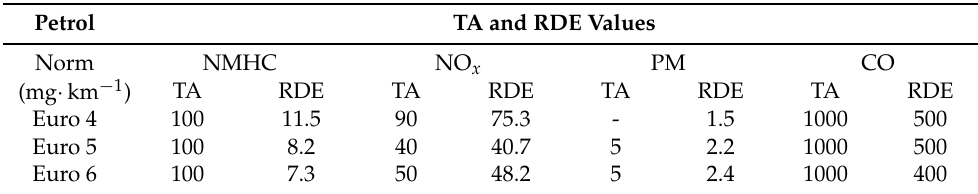
Table 4. Overview of the type approval (TA) values and applied real driving emission (RDE) values for the regulated pollutants for diesel cars (based upon [21,39,43,54–57]). Diesel TA and RDE Values Norm NMHC NO x PM CO (mg ¨ km ´ 1 ) TA RDE TA RDE TA RDE TA RDE Euro 4 500 202 Euro 5 50 180 820 Euro 6 50 11.4